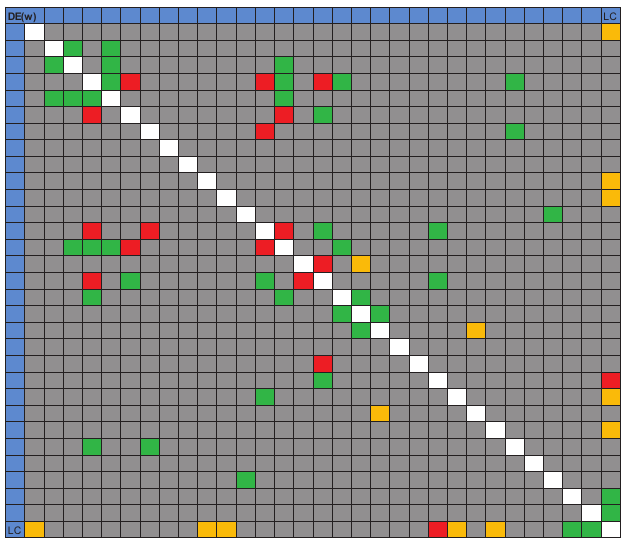
LC LC stands for the large carnivore species in focus. The blue cells represent the respective amount of individual stakeholders listed during the workshop. Colors of the intersecting cells reveal the quality of the relationships between any pair. Green = positive relationship, yellow = neutral relationship, red = negative relationship, gray = no